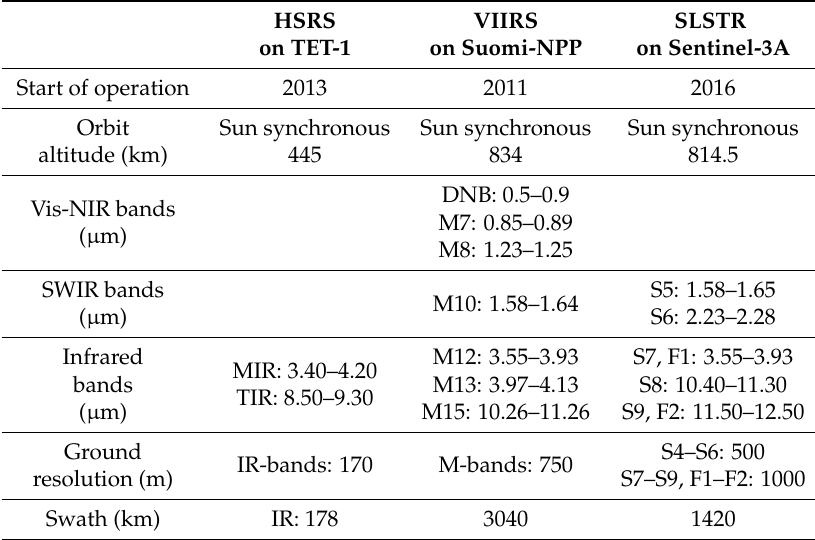
Table 1 summarizes the specifications of the used sensors, while Table 2 summarizes the data used. Table 1. Comparison between the used sensors.